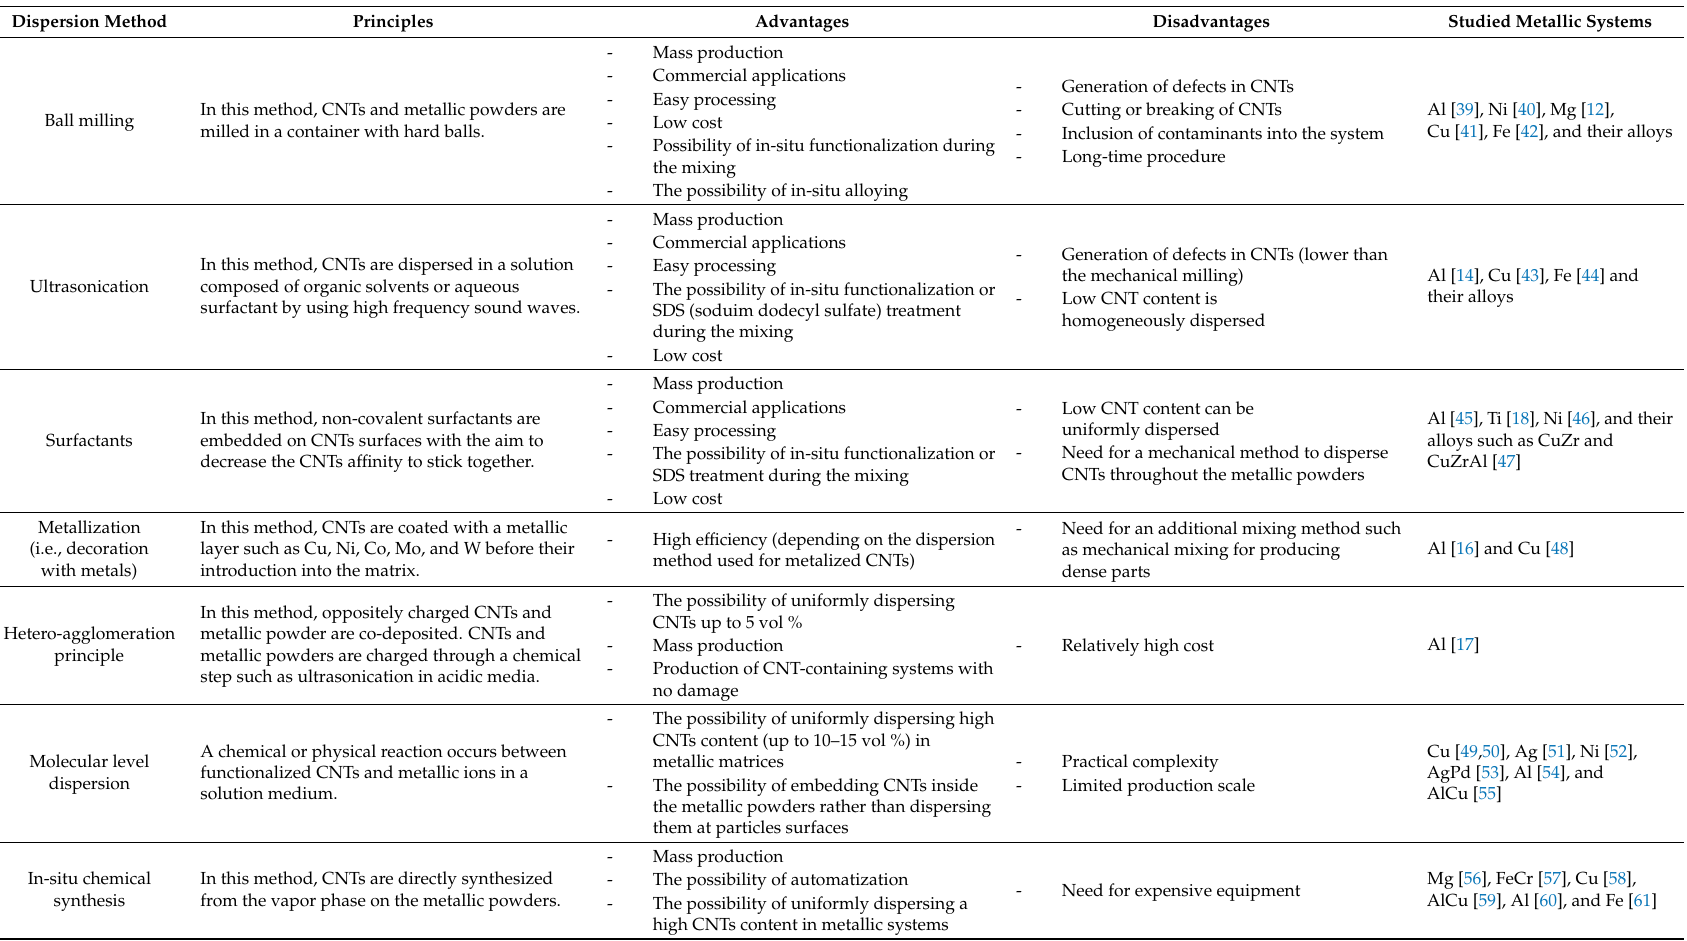
Table 1. A short description of CNTs (carbon nanotubes) dispersion methods in metal matrix nanocomposites, their advantages and disadvantages. Dispersion